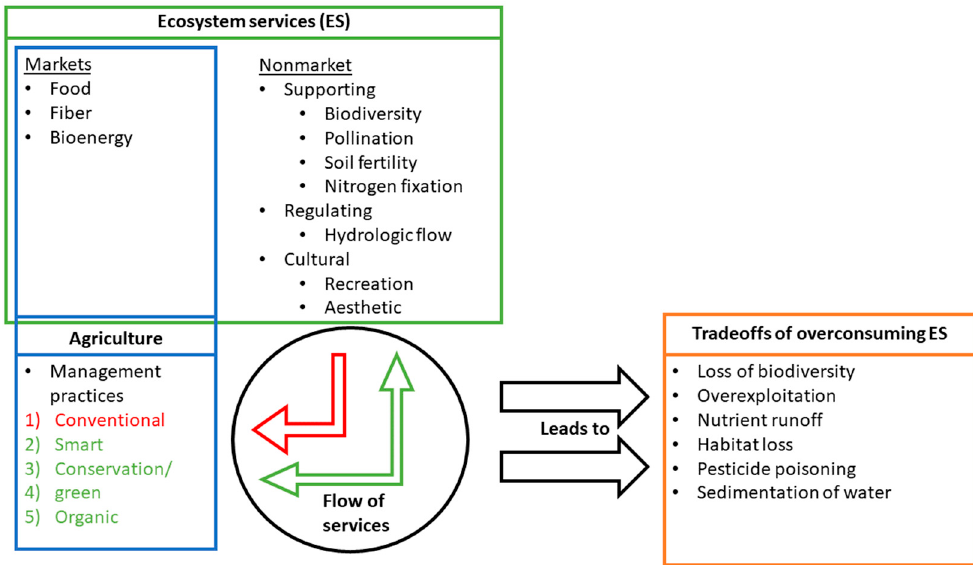
Figure 1. Joint ecosystem and agriculture modeling framework highlighting integrated nature of systems [96,103].